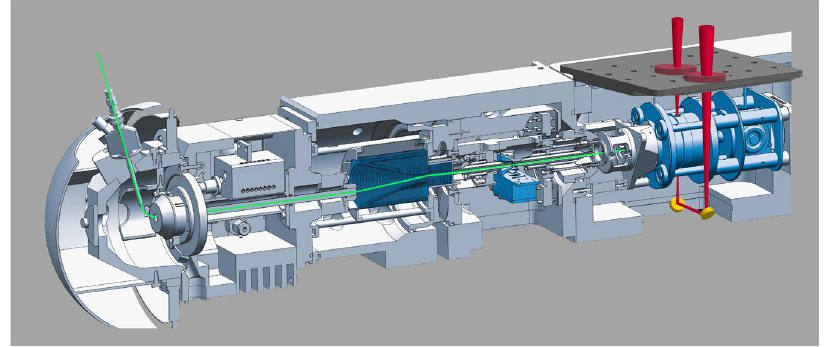
Figure 3. An Ion trap mass spectrometer modified for infrared ion spectroscopy. Gas phase ions are generated by direct infusion electrospray ionization and are transferred (green) to the ion trap where ions of a single m/z value are isolated and stored. Subsequently, a tunable infrared laser (red) irradiates the ions and generates a frequency-dependent photodissociation spectrum as the laser frequency is